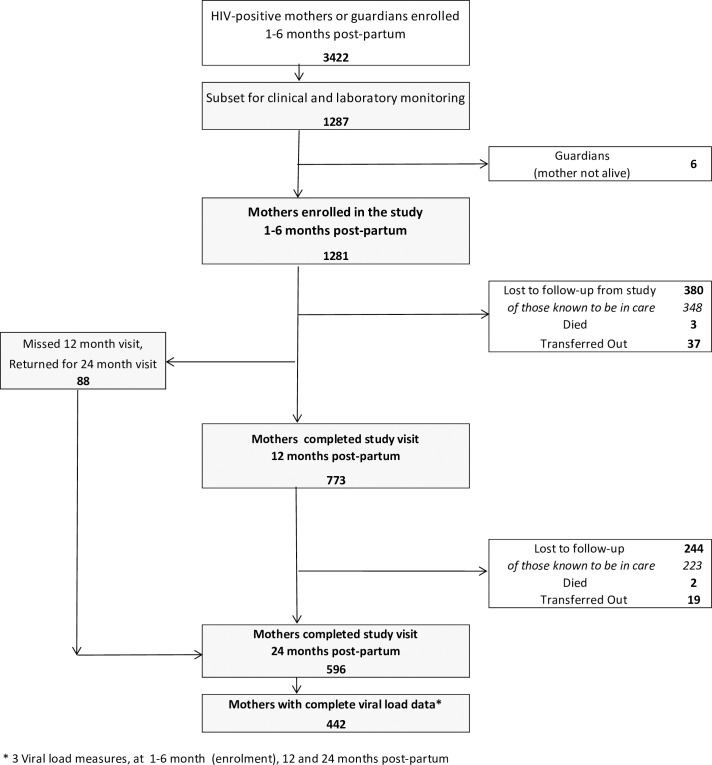
Mothers enrolled, followed and retained in the study up to 24 months post-partum.